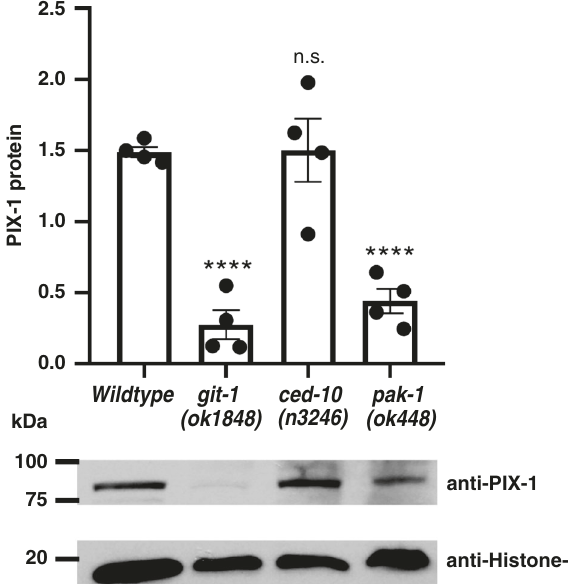
Fig. 8 PIX-1 levels are reduced in git-1 and pak-1 mutants. Equal quantities of total SDS-soluble proteins from wild type, git-1(ok1848) , ced-10(n3246), and pak-1(ok448) , were resolved on a gel, blotted to the membrane and reacted with anti-PIX-1, and as a loading control with anti-histone H3. After normalization to the amount of histone H3, the levels of PIX-1 in the mutants were compared to the level of PIX-1 in wild type. Representative immunoblot results are shown below the graph. N = 4 independent western blot reactions from each strain; means and standard error of the means are shown; git-1 and pak-1 mutants show statistically different levels from wild- type based on a two-sided student ’ s t -test at p ≤ 0.0001 (indicated by ****). Images of the entire western blots are provided in the Source Data